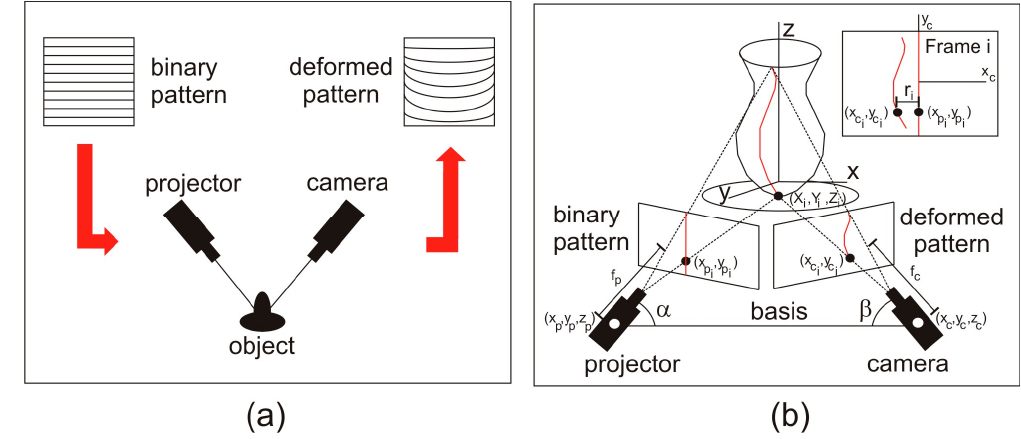
Figure 1. ( a ) Photogrammetric triangulation for the binary code used in this work; ( b ) Outline of the process of obtaining 3-Dimensional Surface Digital Models (3DSDM) of objects using the Structured Light System Technique (SLST).